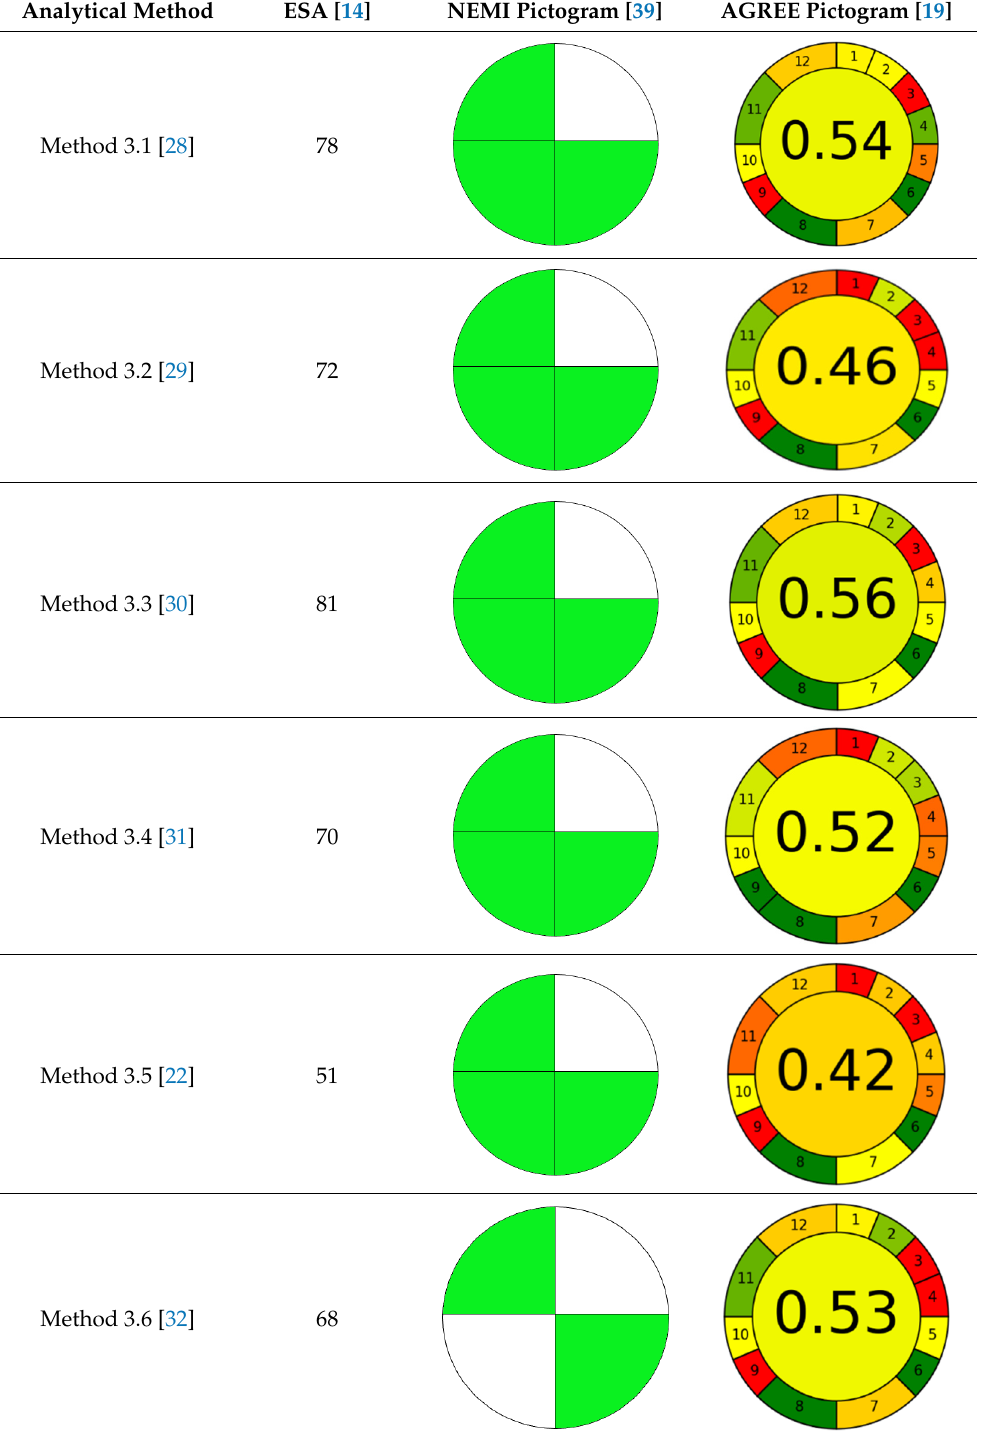
Table 3. Greenness assessment results of methamphetamine and tramadol analytical procedures.